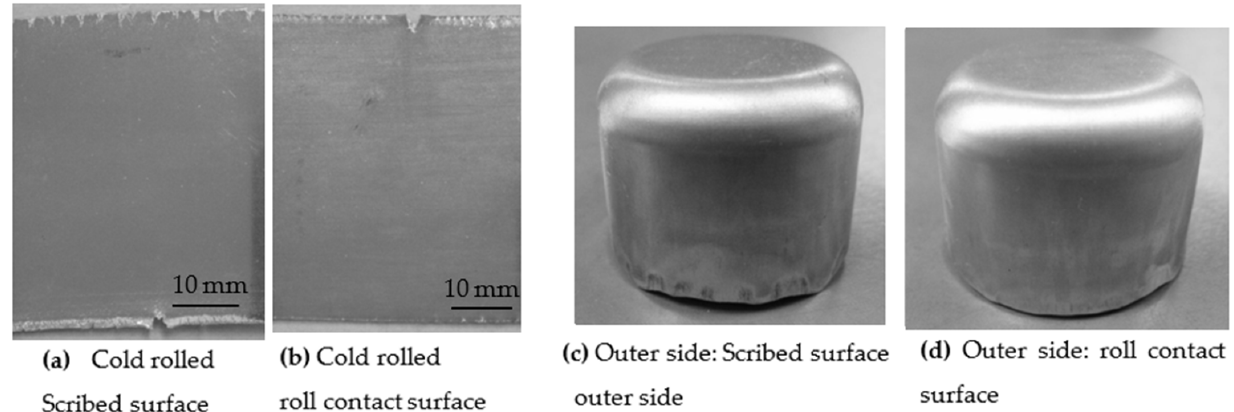
Figure 23. Surfaces of cold rolled 1-mm-thick 5182 strip and results of deep drawing tests using cold rolled and annealed 1-mm thick 5182 strip. Punch diameter was 32 mm and blank holder pressure was 1.2 kN.